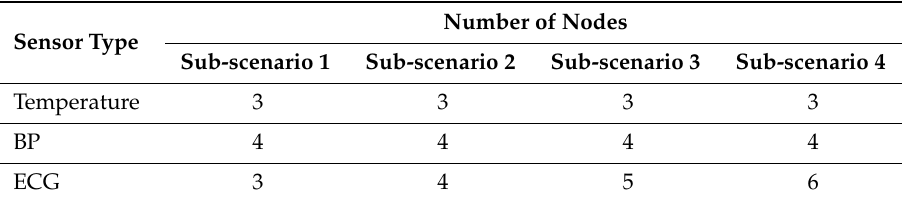
Table 7. Deployment of sensors in Scenario